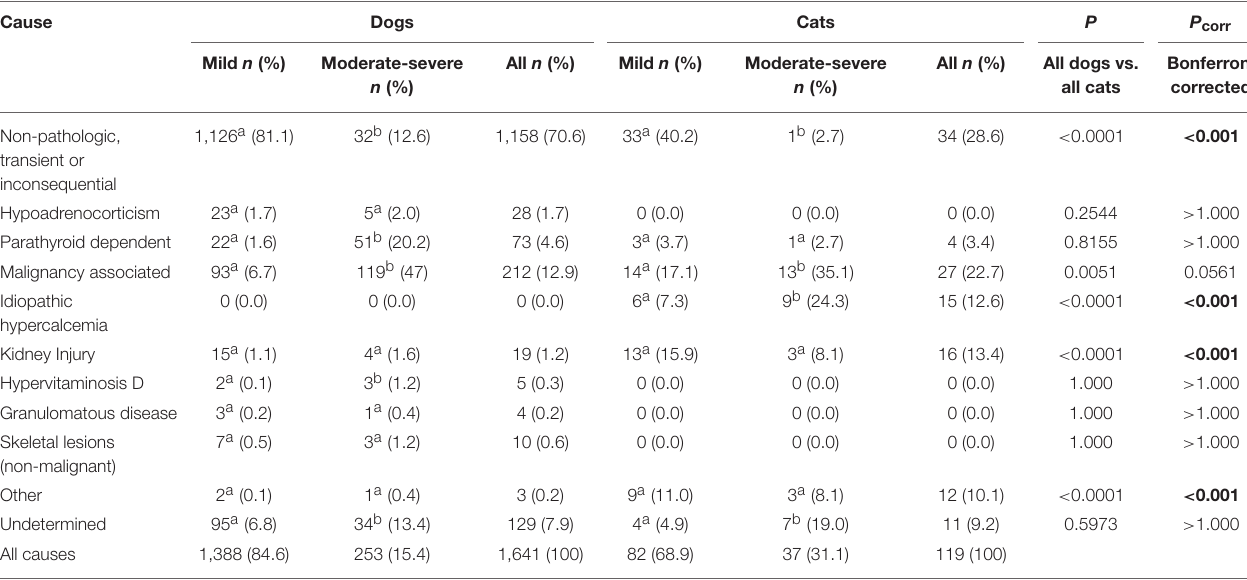
TABLE 1 | Conditions associated with